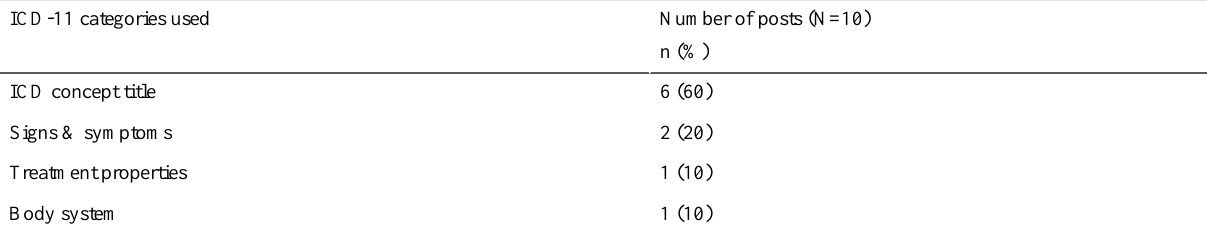
Table 2. The ICD-11 categories used to classify posts (for the gastroenterology blog).